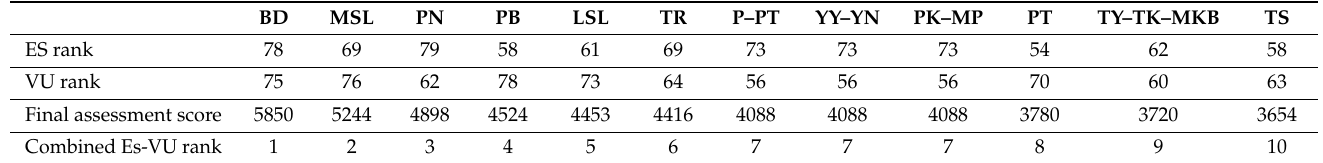
Table 4. Twelve sties ranked as the ten highest combined scores for ecosystem services and vulnerabil-